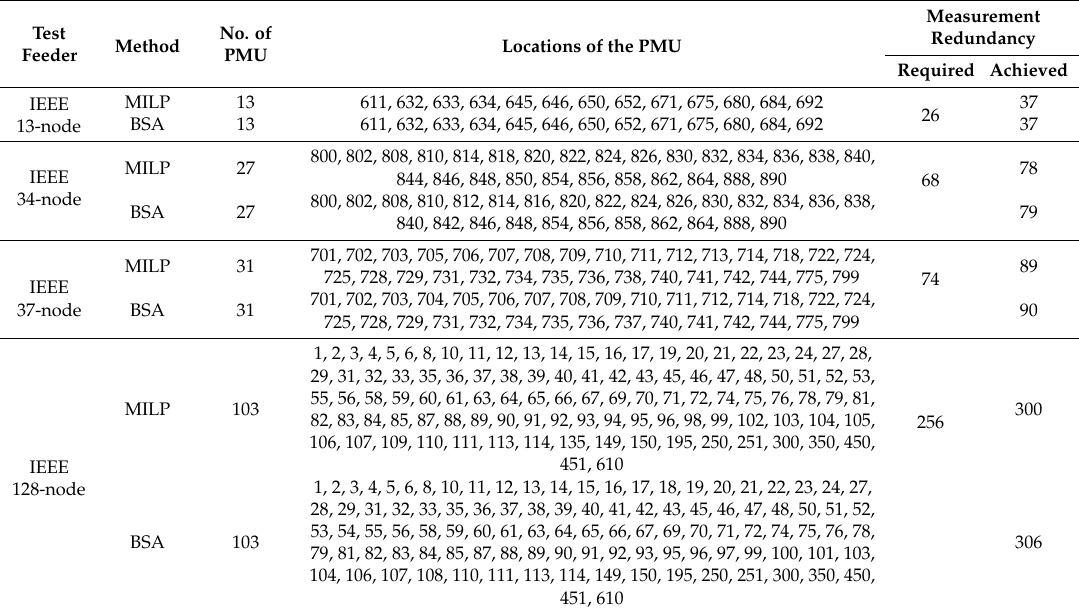
Table 5. Optimal numbers and locations of PMU without considering ZIB and channel limits during single PMU loss case.